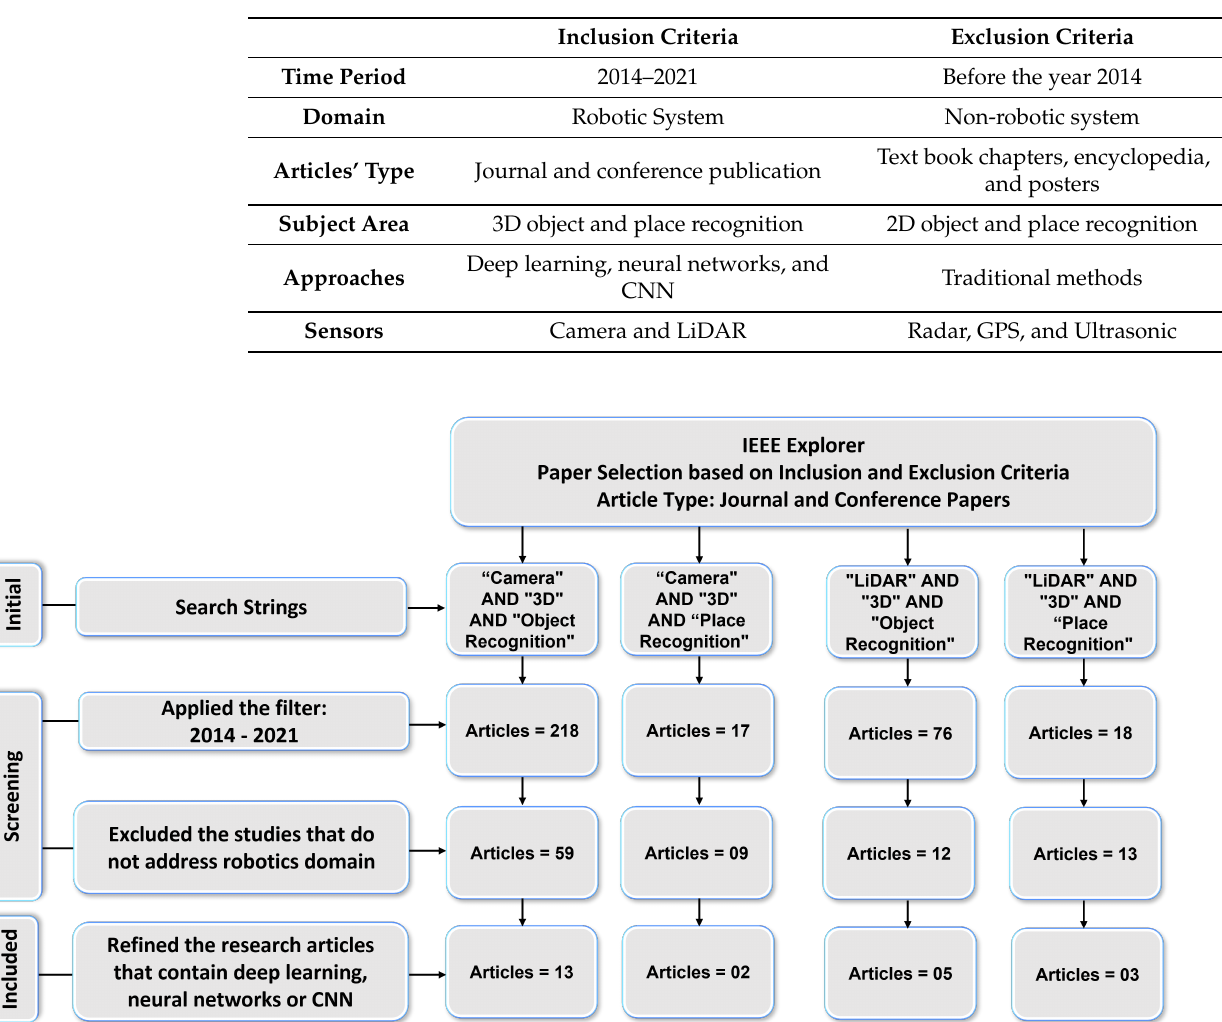
Table 2. 3D Recognition: Inclusion and Exclusion Criteria.